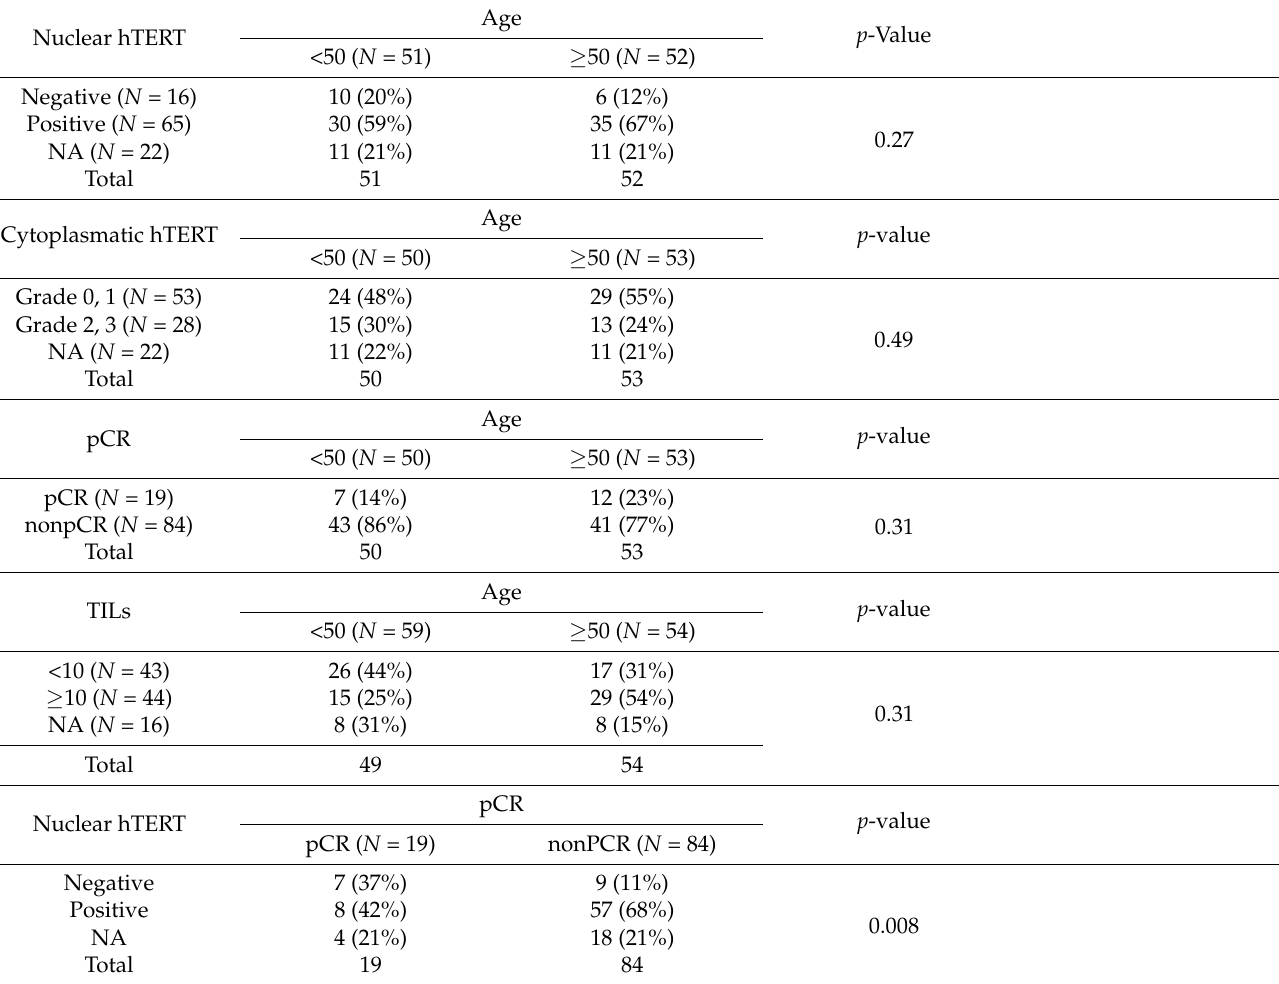
Table 4. Significance assessment between hTERT expression and the clinical